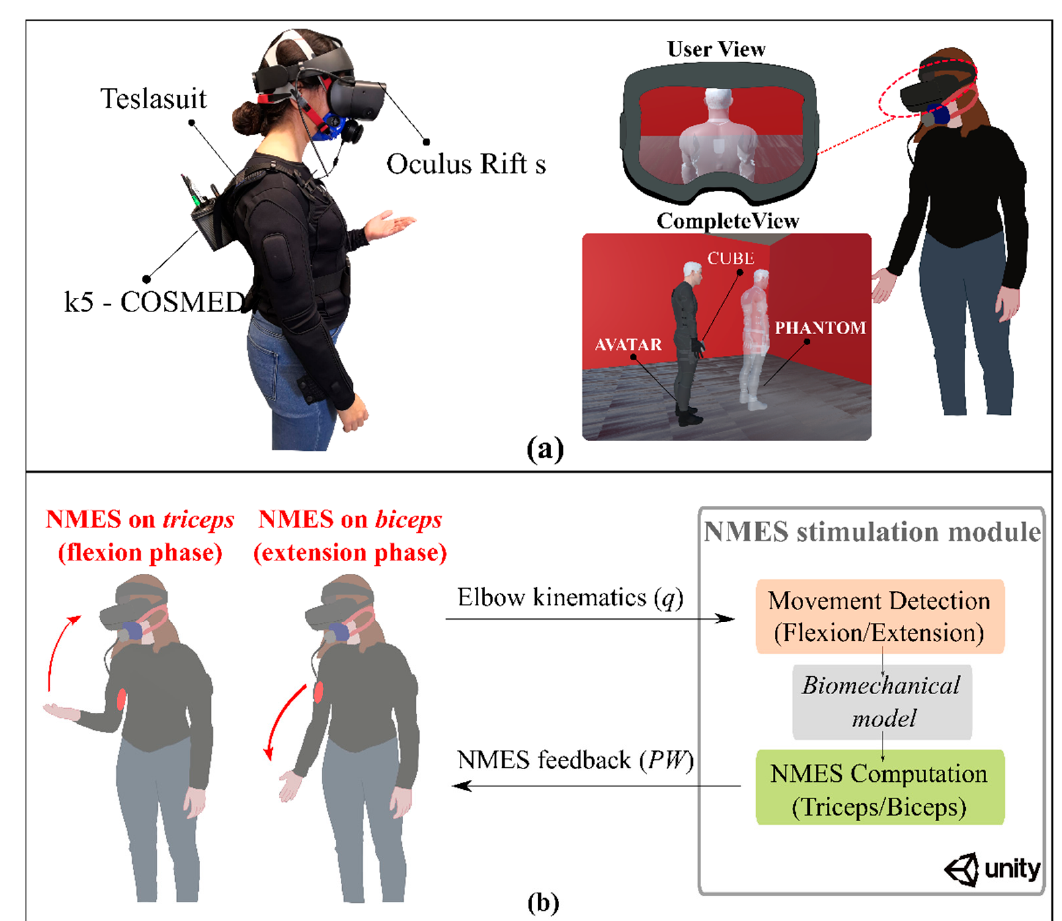
Figure 1. ( a ) Experimental setup: the subject while wearing the NMES-based suit (Teslasuit), the 3D visor (Oculus Rift s), and the metabolic consumption device (k5-Cosmed). On the right is shown the scenario rendered on the 3D visor during the task (user view). Underneath represents the complete view of the implemented virtual scenario in which the user can see its posture (black avatar) and the one to match (white avatar) while handling the virtual cube (cube). ( b ) Real-time control scheme of the NMES-based haptic feedback: the biomechanical model implemented within the NMES stim- ulation module , received as input of the elbow angle read by the suit sensors and, depending on the phase of the elbow movement (flexion/extension, red arrows), delivered electrical stimulation to the respective muscle antagonistic to the one activated during the detected phase (triceps/biceps, red